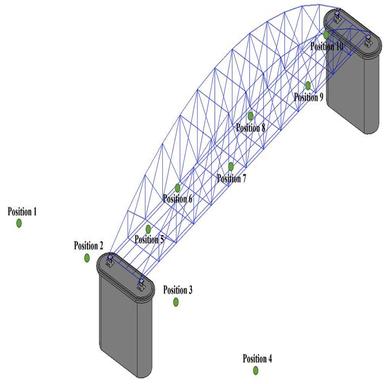
Scheme of laser scan positions.